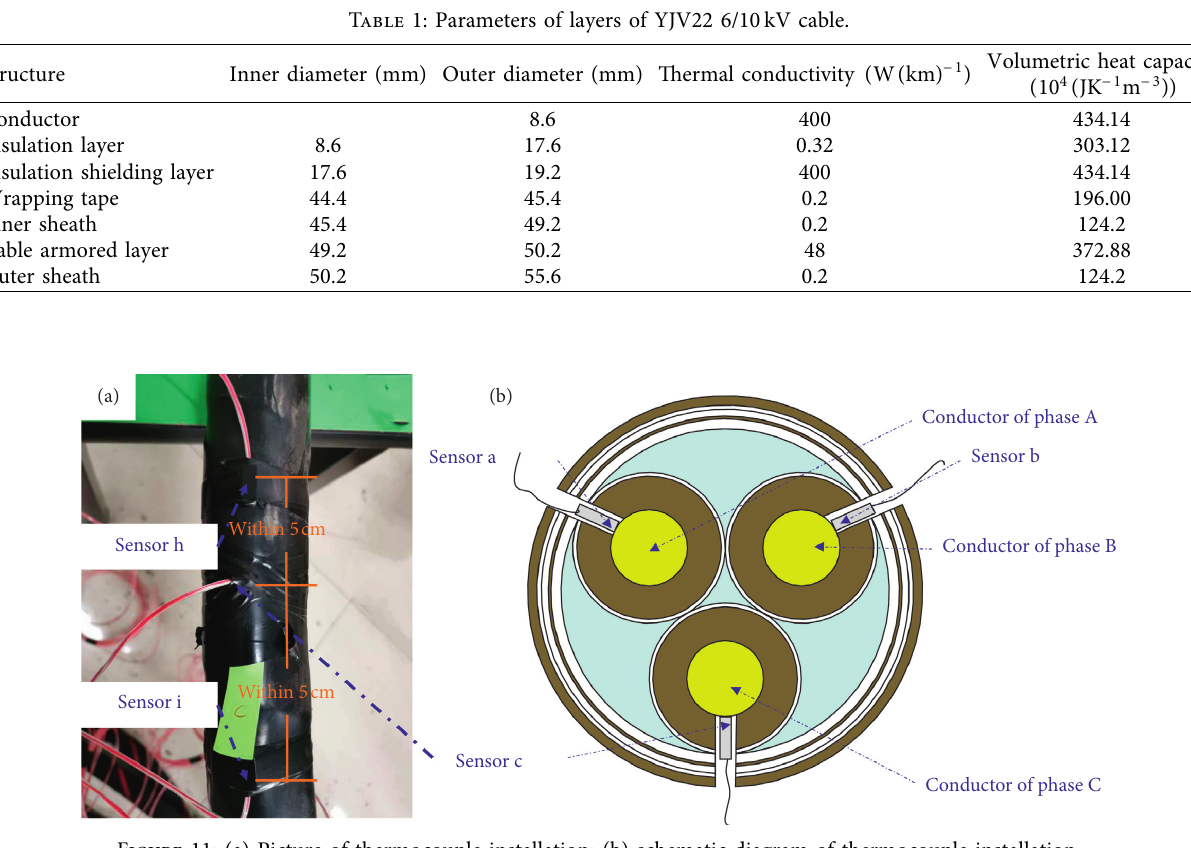
Figure 11: (a) Picture of thermocouple installation; (b) schematic diagram of thermocouple